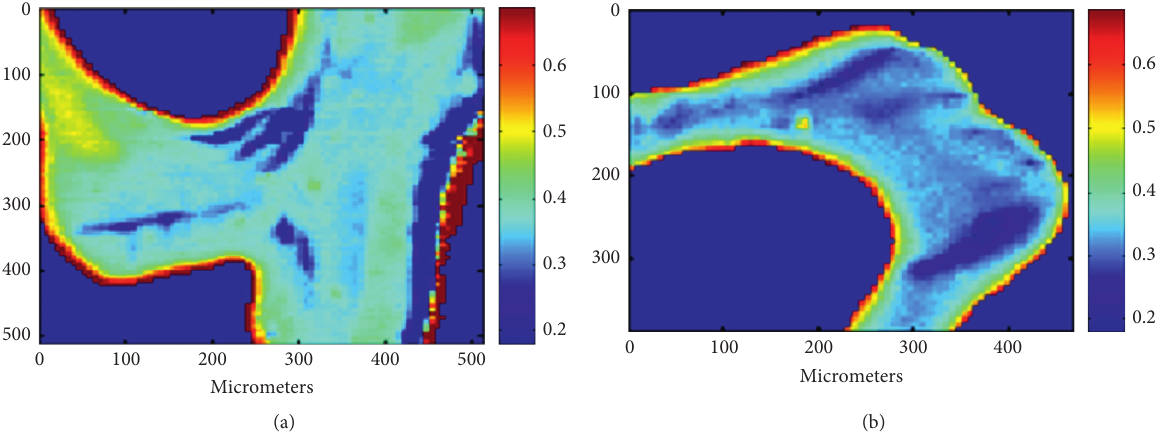
Figure 1: The FTIR images of acid phosphate substitution in iliac crest trabecular bone. All numbers represent scales of micrometer. (a) Patients with high uNTX (39nmol BCE/mmol · Cr). (b) Patients with low uNTX (14nmol BCE/mmol ·